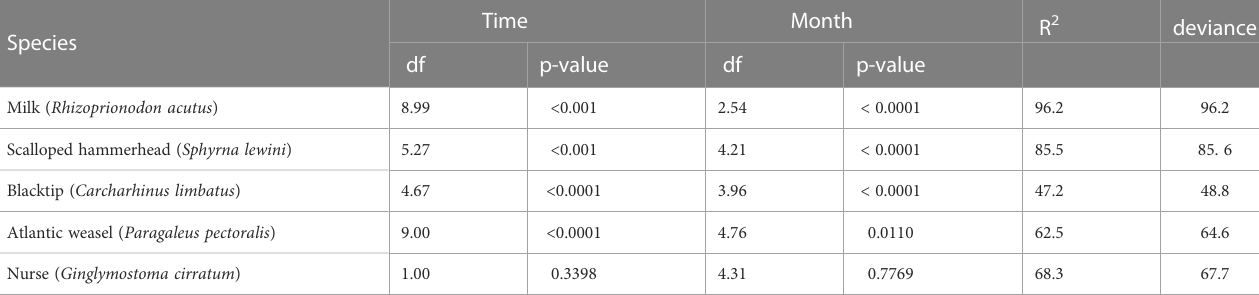
Results presented correspond to outputs for Generalized Additive Models (Gaussian family with a log link) depicting the smooth effects (estimated degrees offreedom and p-value associated with testing the need for the term to be included in the model) of time and cyclic smooth effect of month on CPUE per each shark species. Also shown the R 2 and the % of deviance